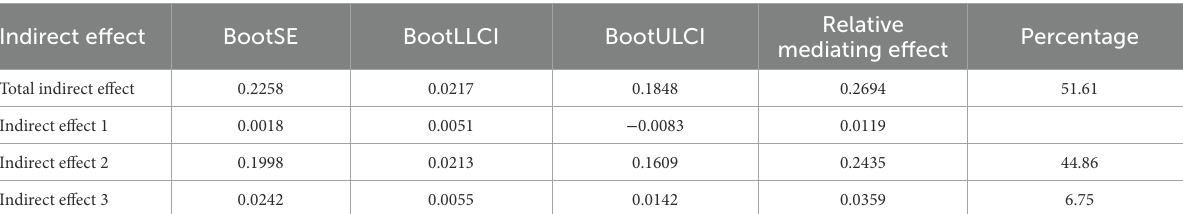
TABLE 8 Analysis of the mediation effect.